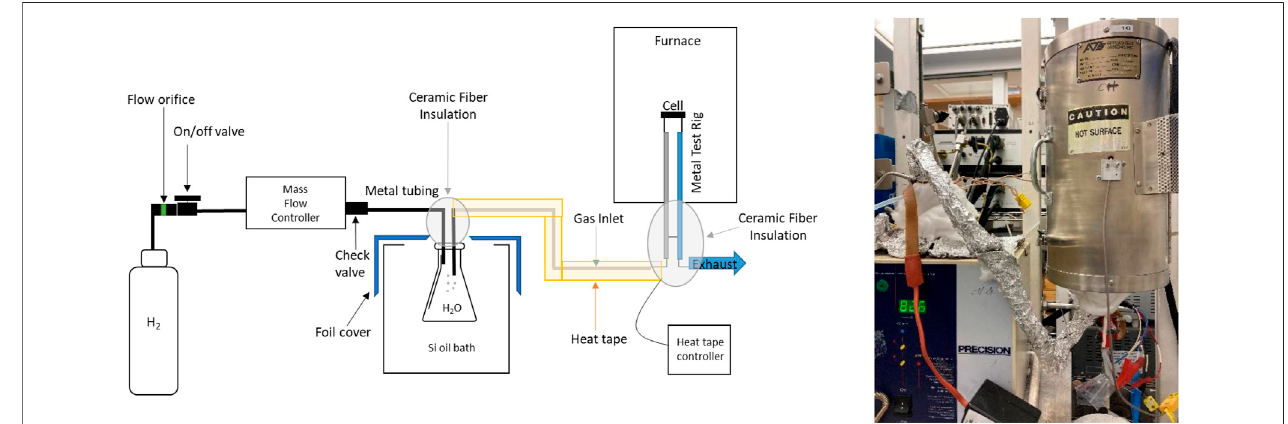
FIGURE 1 | Schematic and photograph of a MS-SOEC test setup with a heated bubbler as the humidi fi cation system.